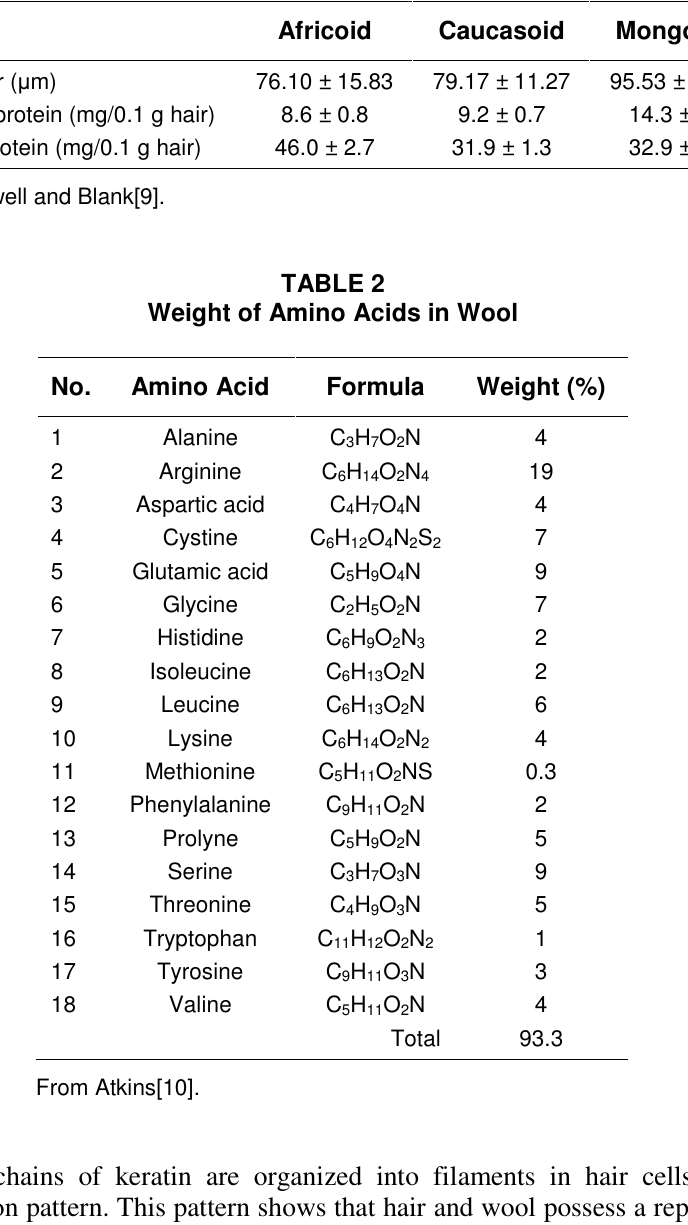
Morphological Properties of Ethnic Hair Types